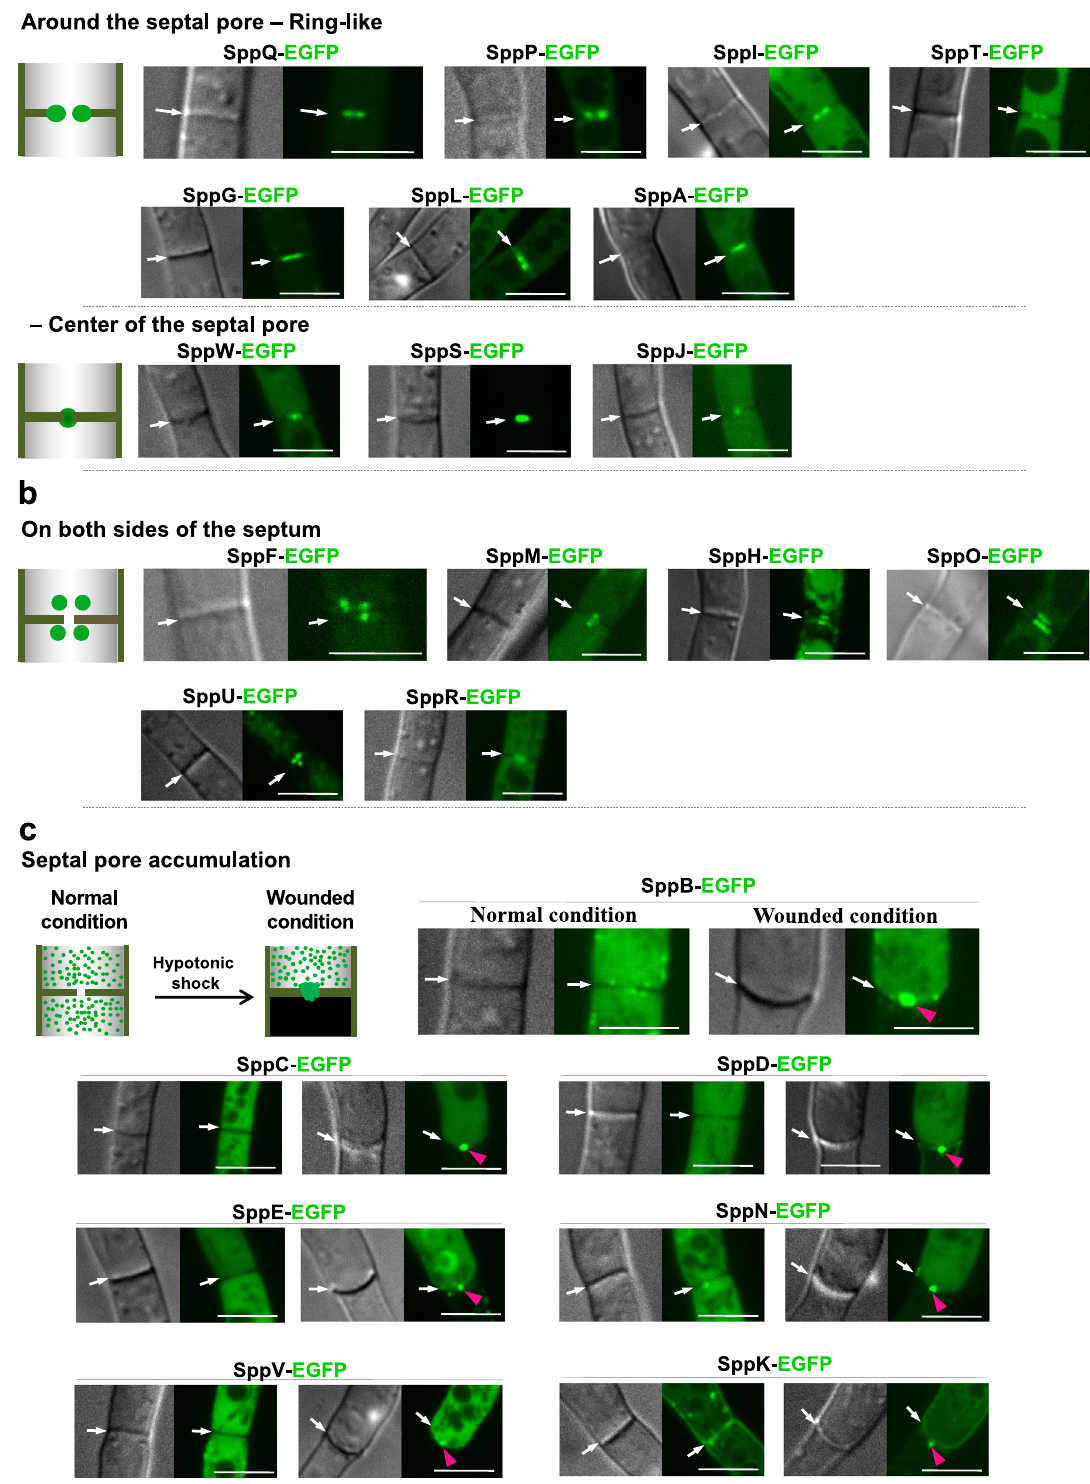
Fig. 3 | Localization of SPP proteins to the septum and septal pore. The apical septa of strains expressing EGFP-fused proteins were analyzed using confocal fl uorescence microscopy under normal, control growth conditions and upon hyphalwounding.Cartoonsrepresentthe localization patterncategories observed